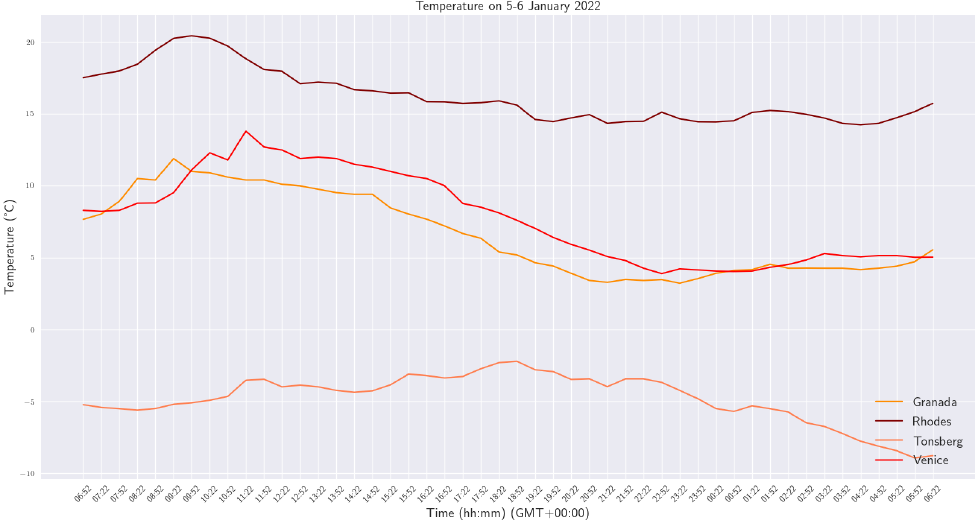
Figure 11. Temperature graph on the four CH sites at 5 and 6 January